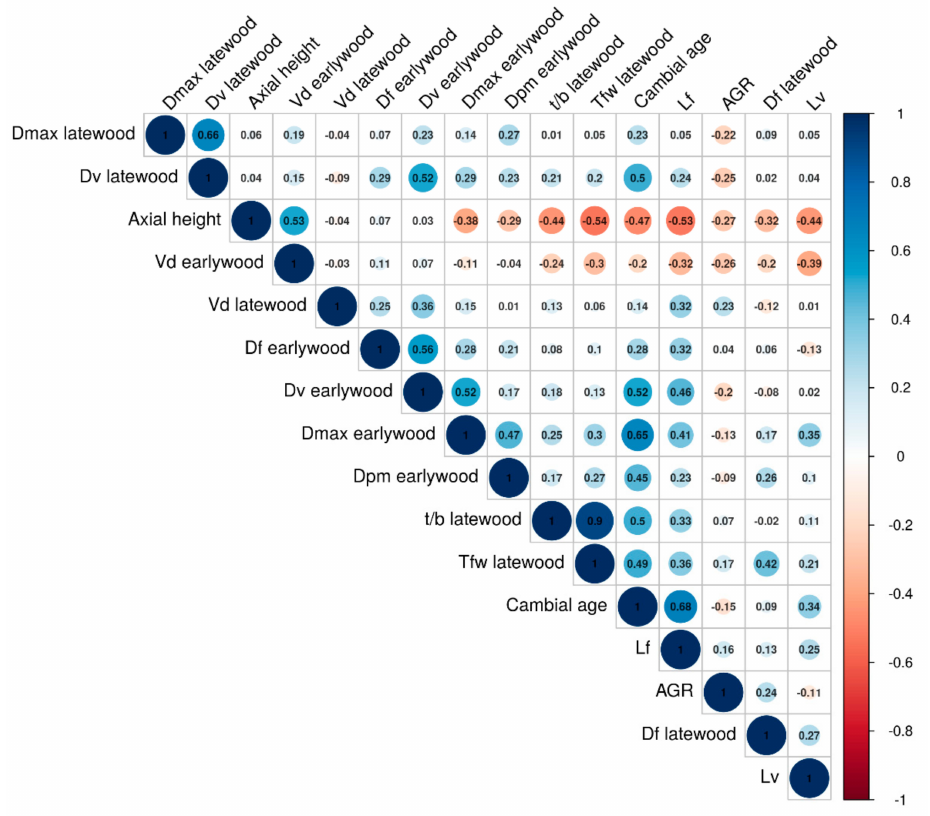
Figure 7. Correlation heat map of the analyzed variables (using the same transformations as in the fitted models). Numbers: Pearson product-moment correlation coe ffi cient; blue: positive correlation; red: negative correlation. AGR, annual diameter growth; see Table 1 captions for remaining